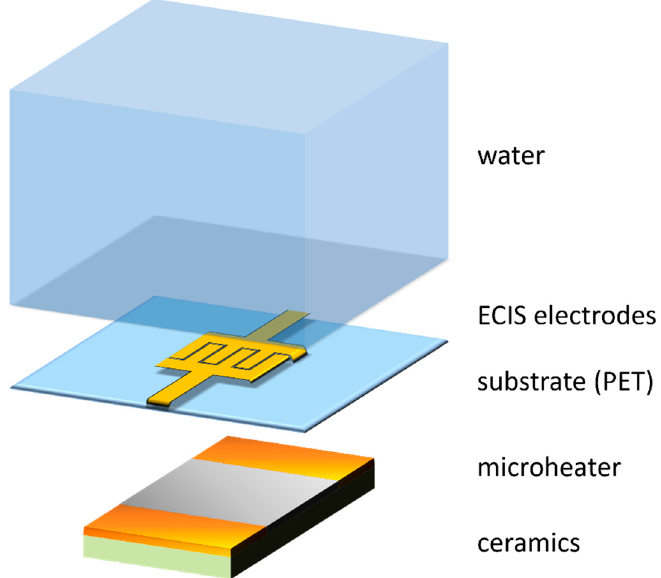
Figure 4. Structure of the cultureware well array with NiCr microheater. Table 1. Physical properties of the